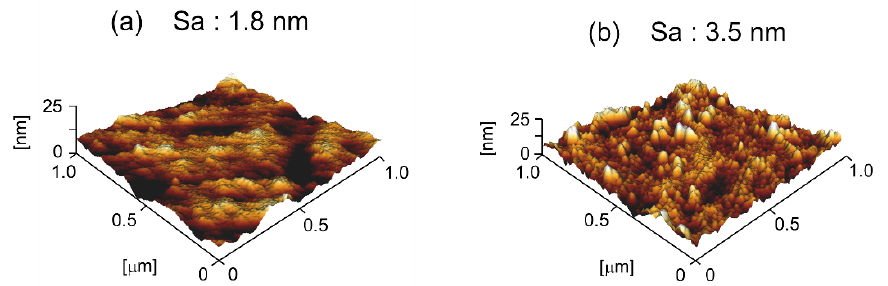
Figure 6. AFM topography images and surface roughness average parameters: ( a ) non-modified PP; ( b ) PP modified with BHA-TBAEMA.